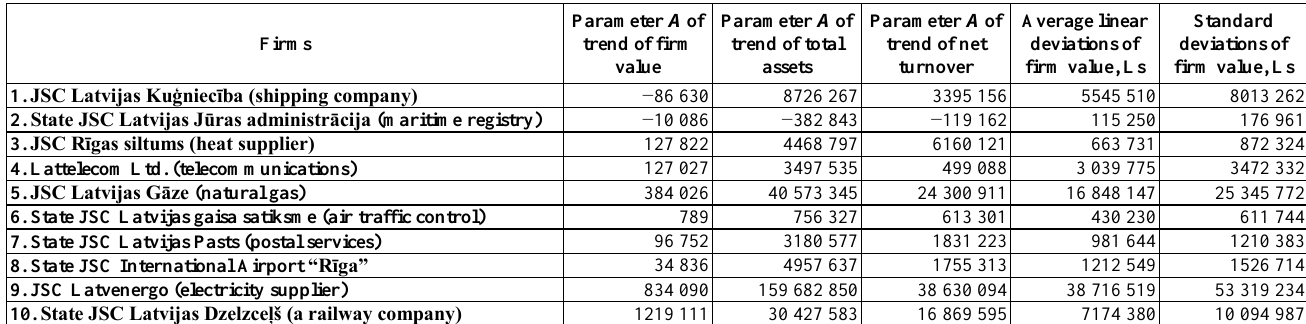
P ARAMETER A OF T REND OF F IRM V ALUE , T OTAL A SSETS AND N ET T URNOVER , A VERAGE L INEAR , S TANDARD D EVIATIONS OF THE C HANGES IN THE V ALUE OF THE L ARGEST L ATVIAN F IRMS (1998–2014) (A UTHORS ’ C ALCULATIONS ON THE B ASIS OF D ATA OF THE R EGISTER OF E NTERPRISES OF THE R EPUBLIC OF L ATVIA